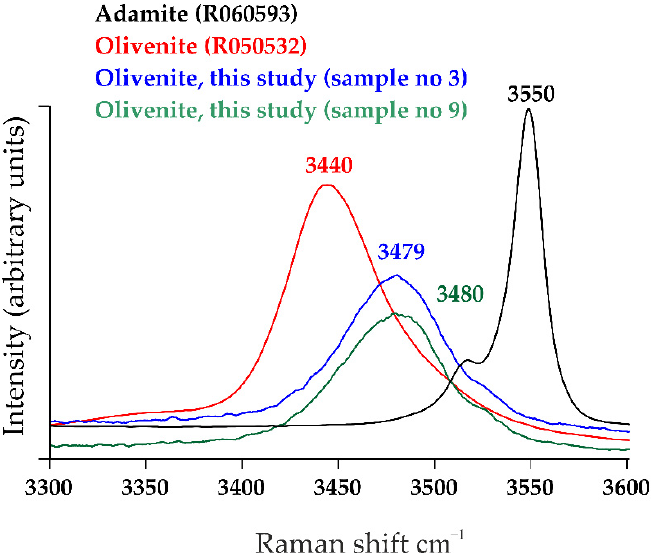
Figure 9. The band of the hydroxyl-stretching region in the reference spectra of olivenite and adamite, and the spectra measured in samples 3 and 9.